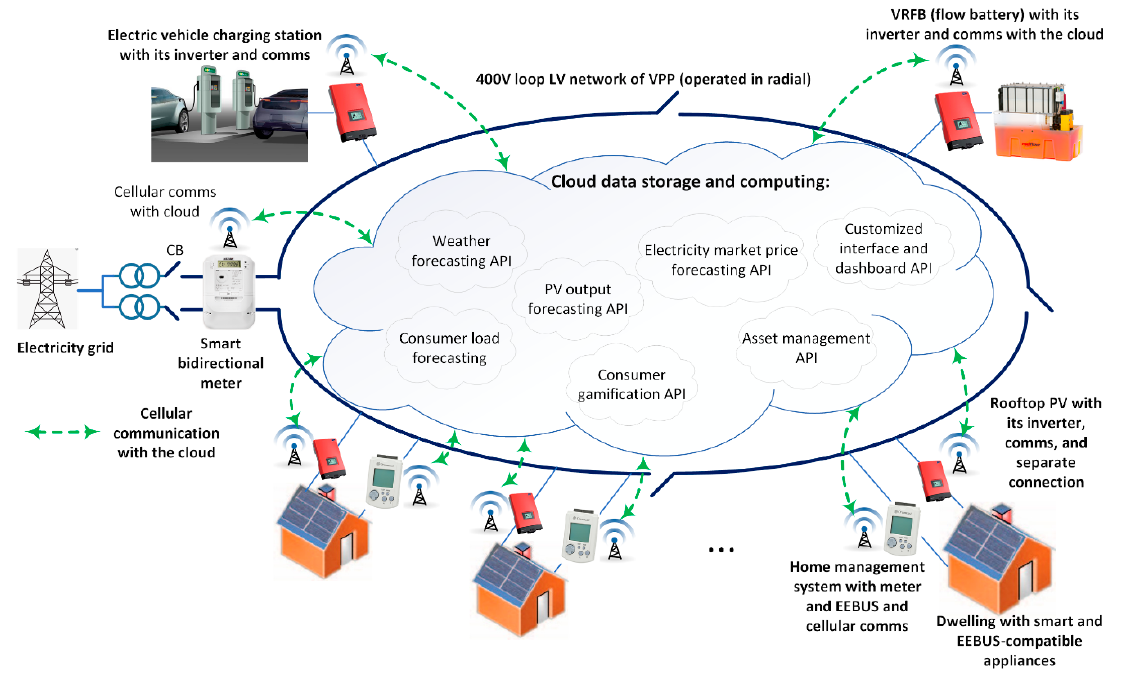
Figure 3. The proposed architecture of the VPP in WA. VRFB: vanadium redox flow battery; PV: photovoltaic; API: appli ‐ cation programming interfaces (CB—Circuit breaker).